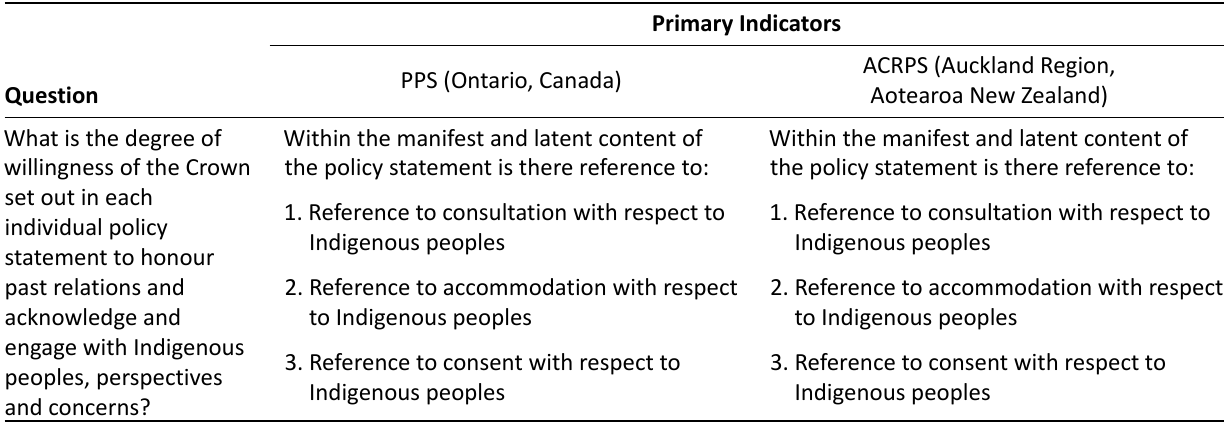
Table 3. Key aspects to Willingness in reference to the Ontario Provincial Policy Statement and the Auckland Council Re- gional Policy